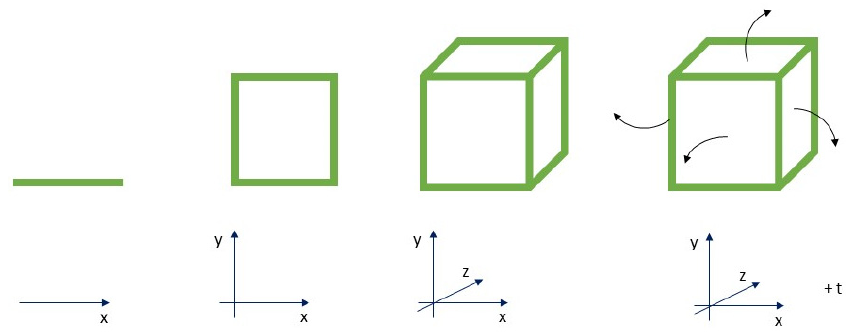
Figure 2. 4D paradigm: complex structures evolving over-time in predictable manner.